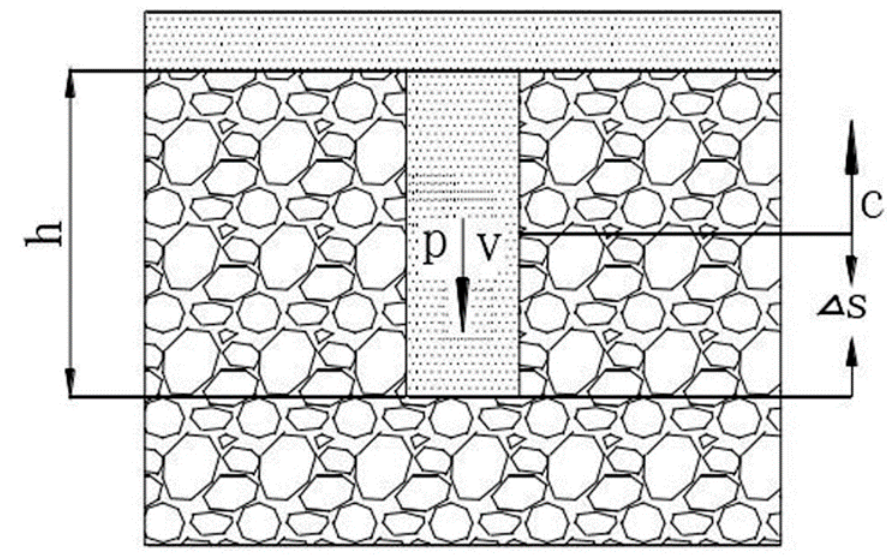
Figure 6. Pore pressure propagation diagram.